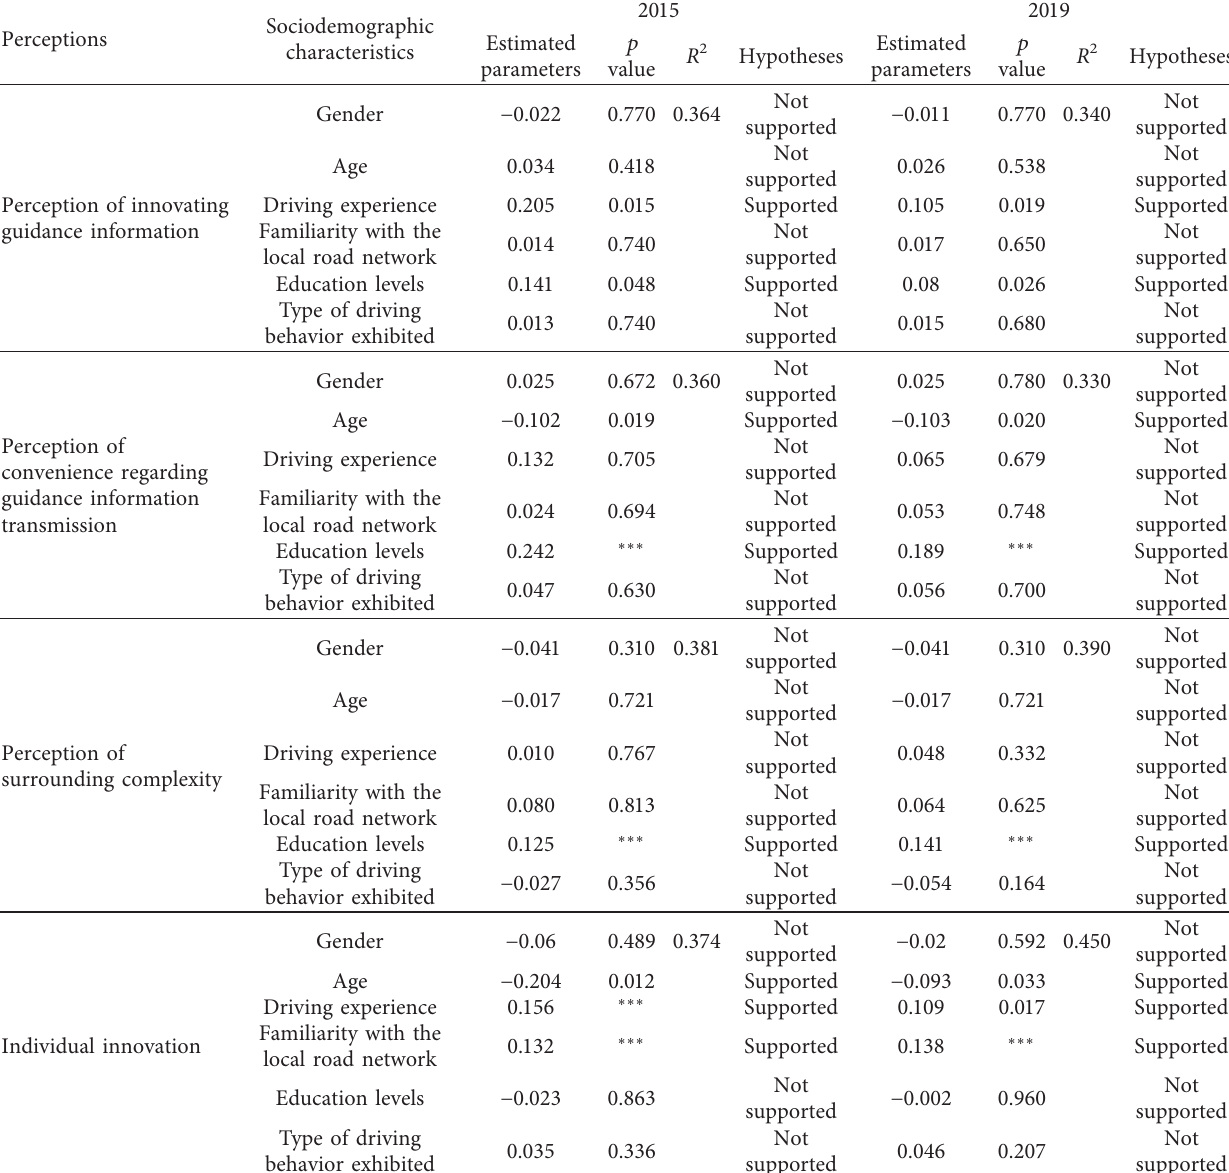
Table 5: Analysis of model hypotheses (2015 and 2019